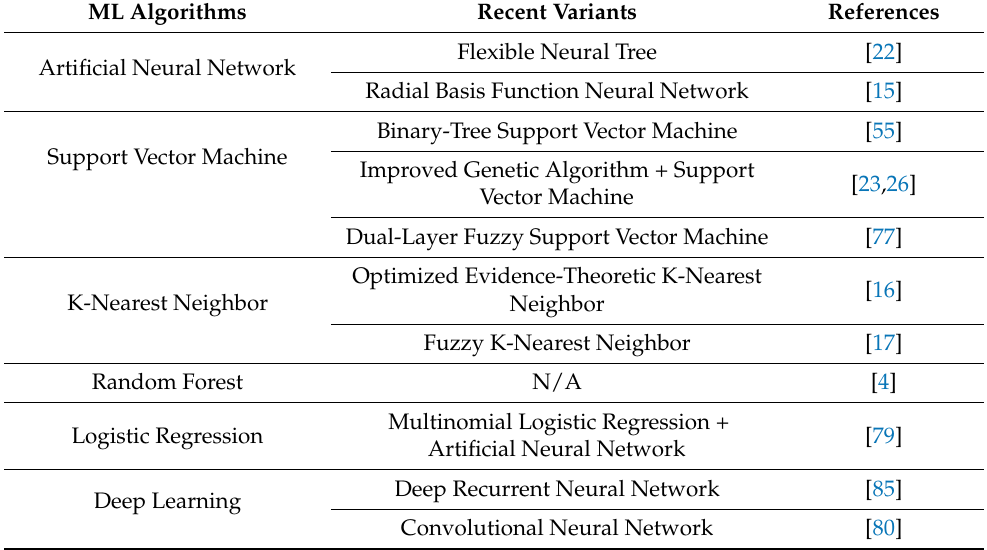
Table 3. List of machine learning algorithms and their recent variants that are frequently used as classification models in the prediction of proteins structural